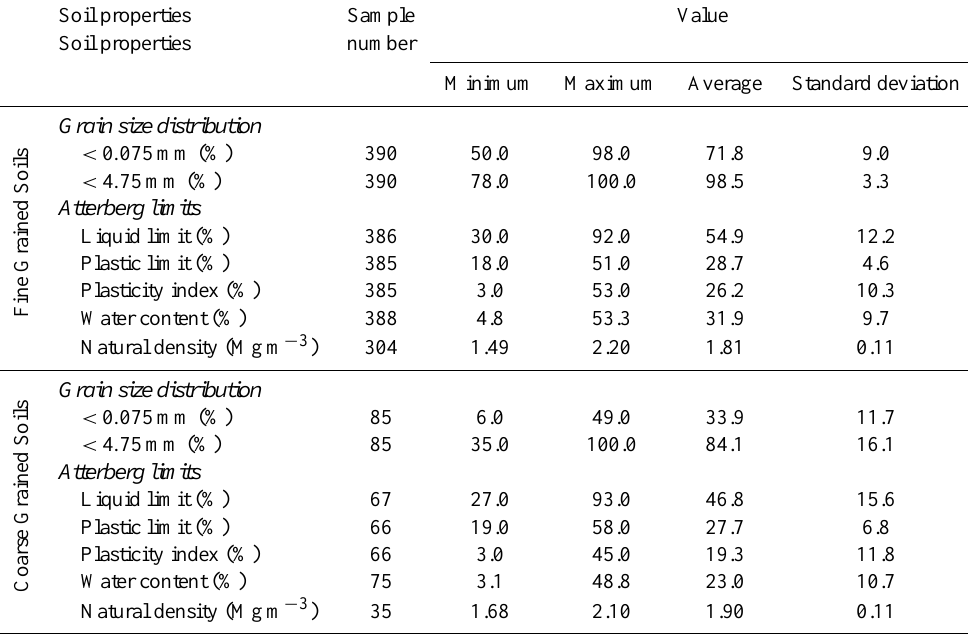
Table 1. Statistical summary of the geotechnical properties of the soil